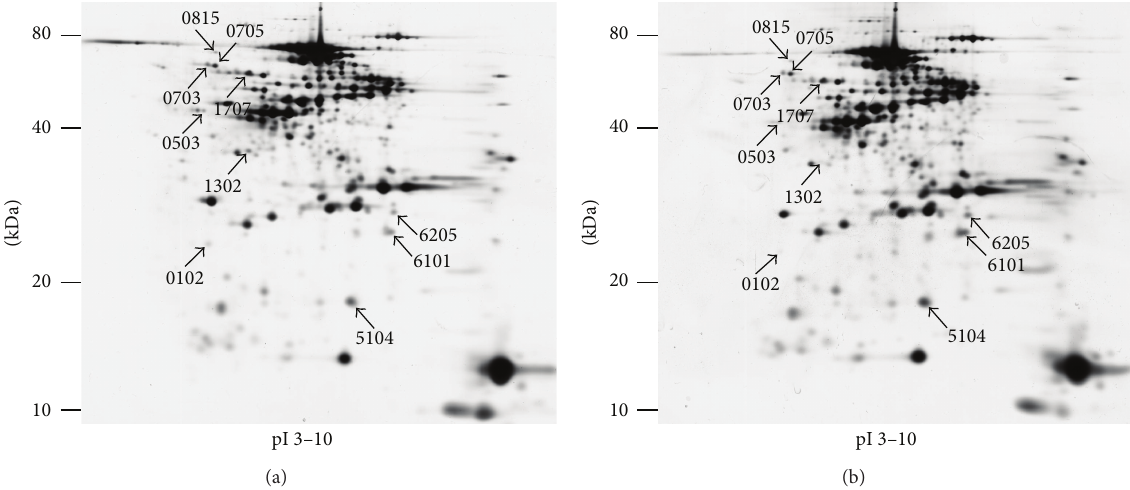
Figure 2: Representative 2D-PAGE images of proteins fractionated from rabbit vitreous. Ten protein spots (arrows) were found to be significantly and at least twofold differentially expressed between the sham (a) and detached (b) vitreous.